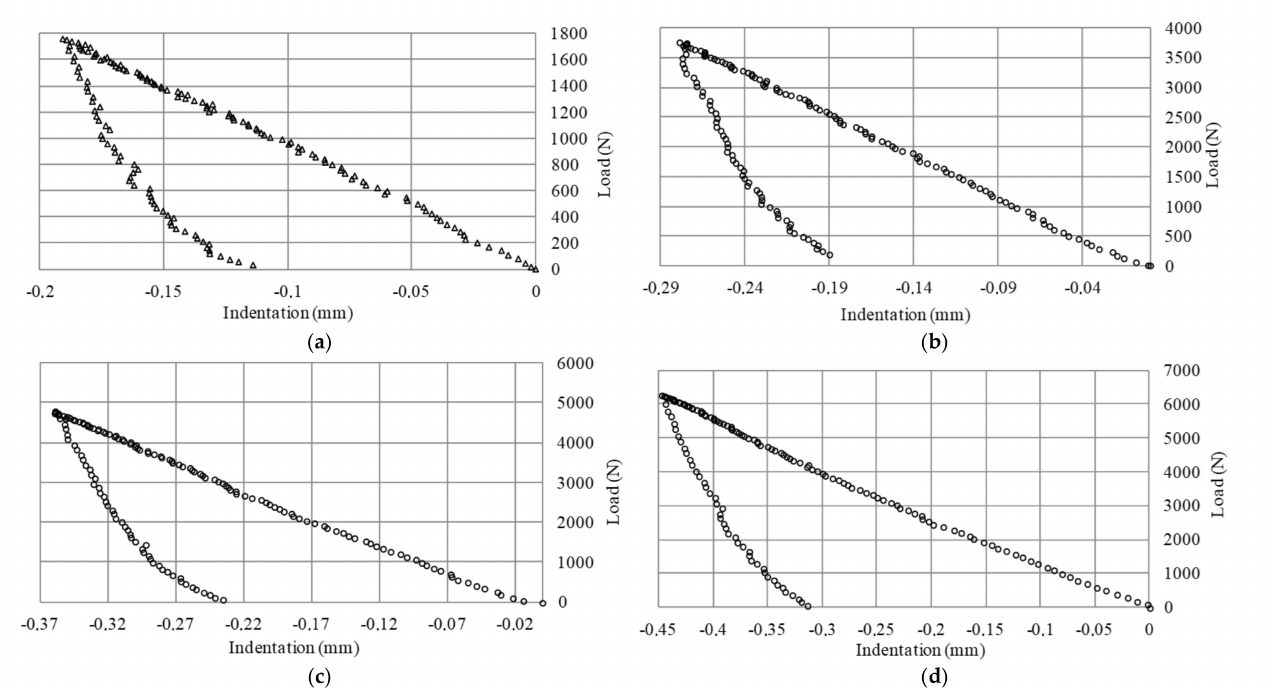
Figure 8. Experimental contact force for: ( a ) 3 mm; ( b ) 4 mm; ( c ) 5 mm and ( d ) 6 mm thick